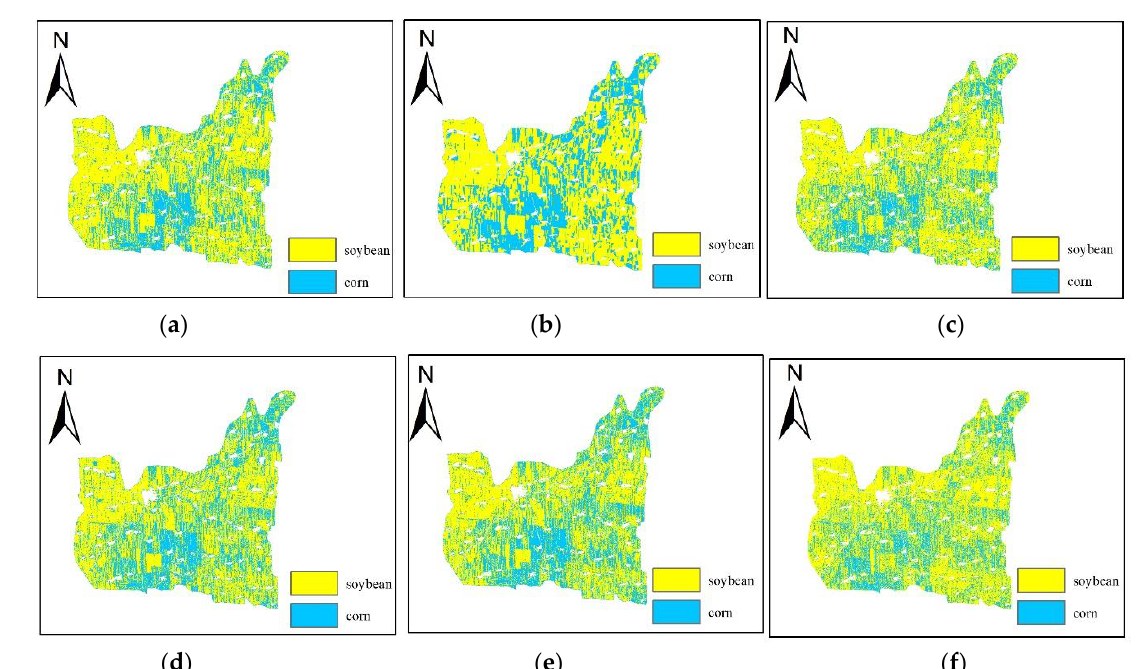
at 2018 (( a ), 10d_size15; ( b ), 15d_size20; ( c ), 30d_size5; ( d ), 10d_Pixel; ( e ), 15d_ Pixel; ( f ), 30d_ Pixel).